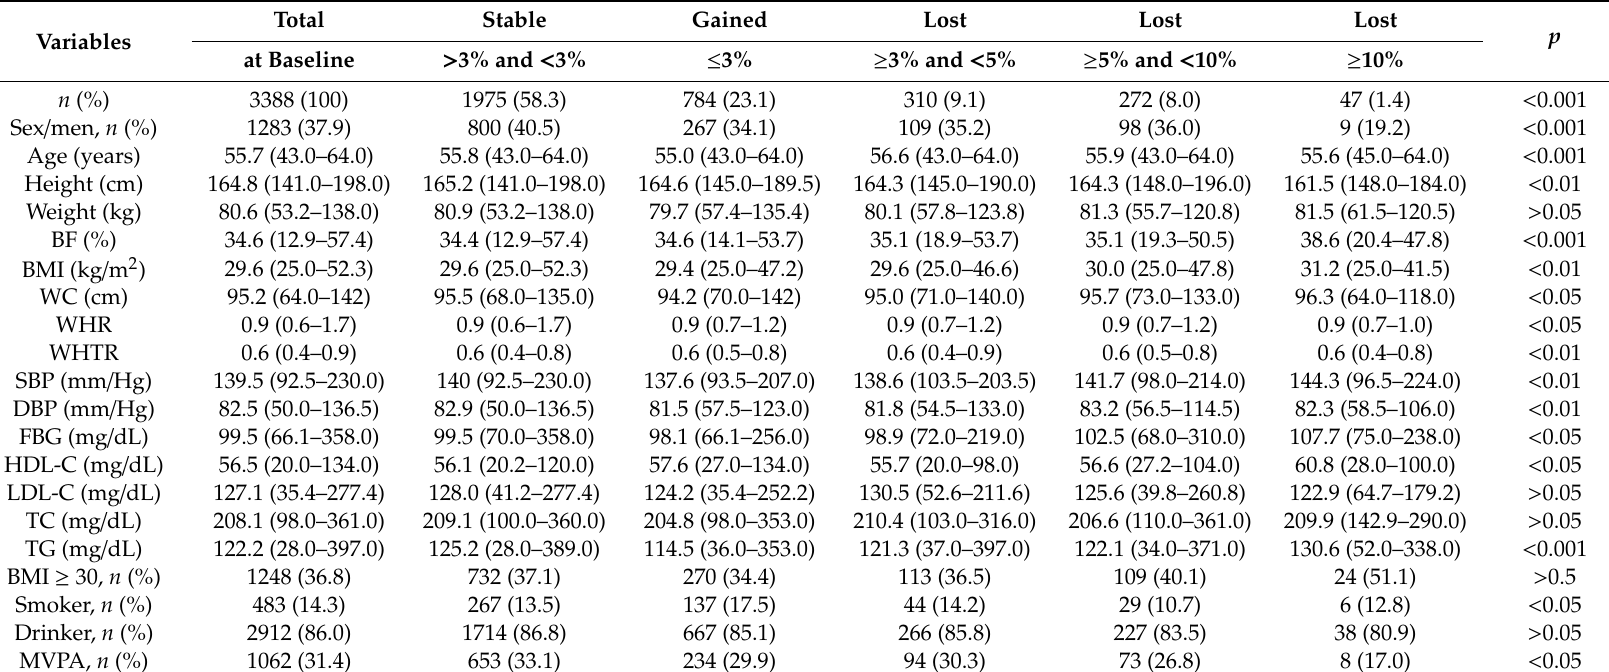
Table 1. Basic characteristics of the study group total at baseline, and by the weight change